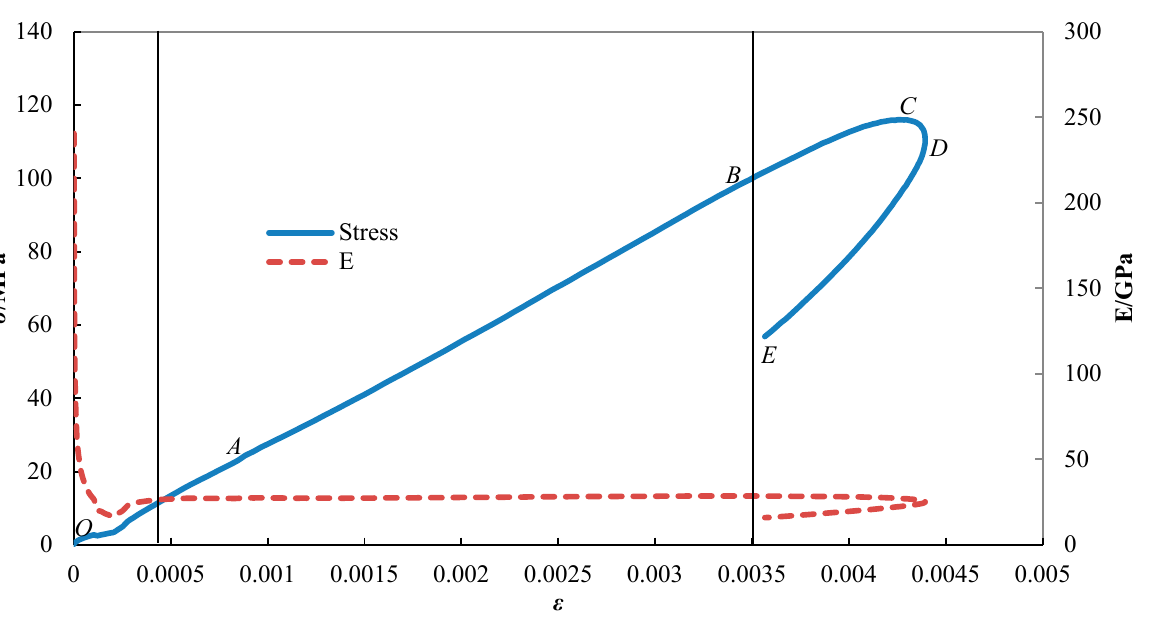
Figure 5. Typical stress ‐ strain curves.